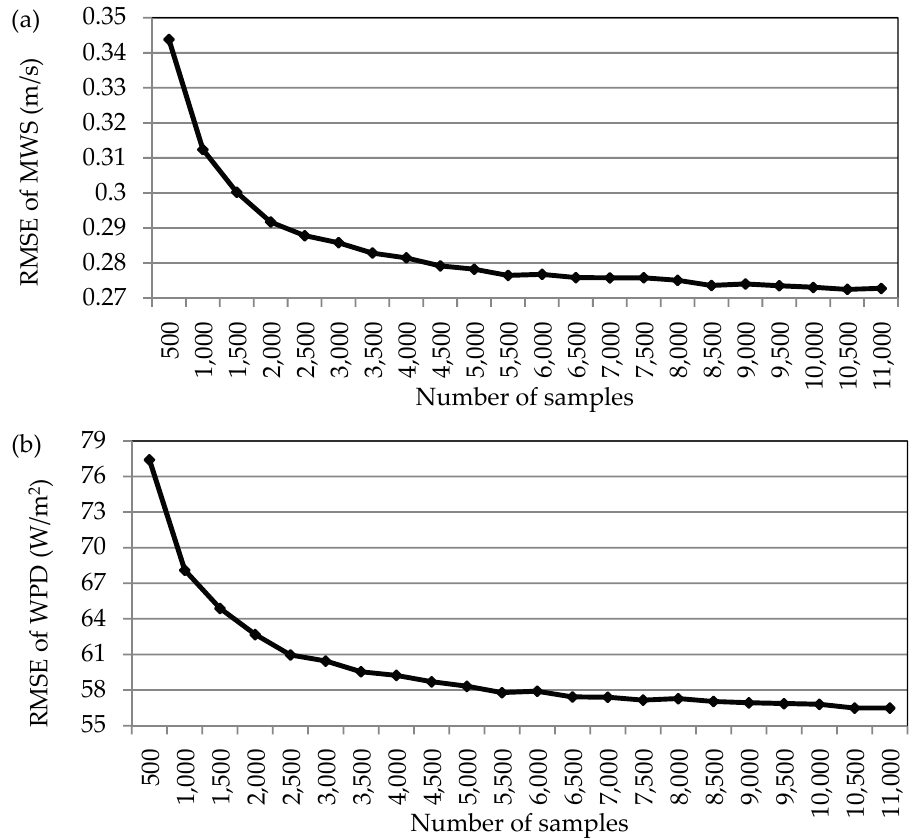
Figure 3. The mean RMSE of MWS and WPD from random sampling of all satellite observations (QuikSCAT + WindSAT + ASCAT) with different numbers of samples compared to the buoy-derived MWS and WPD at a height of 100 m above sea level. ( a ) MWS, and ( b ) WPD.